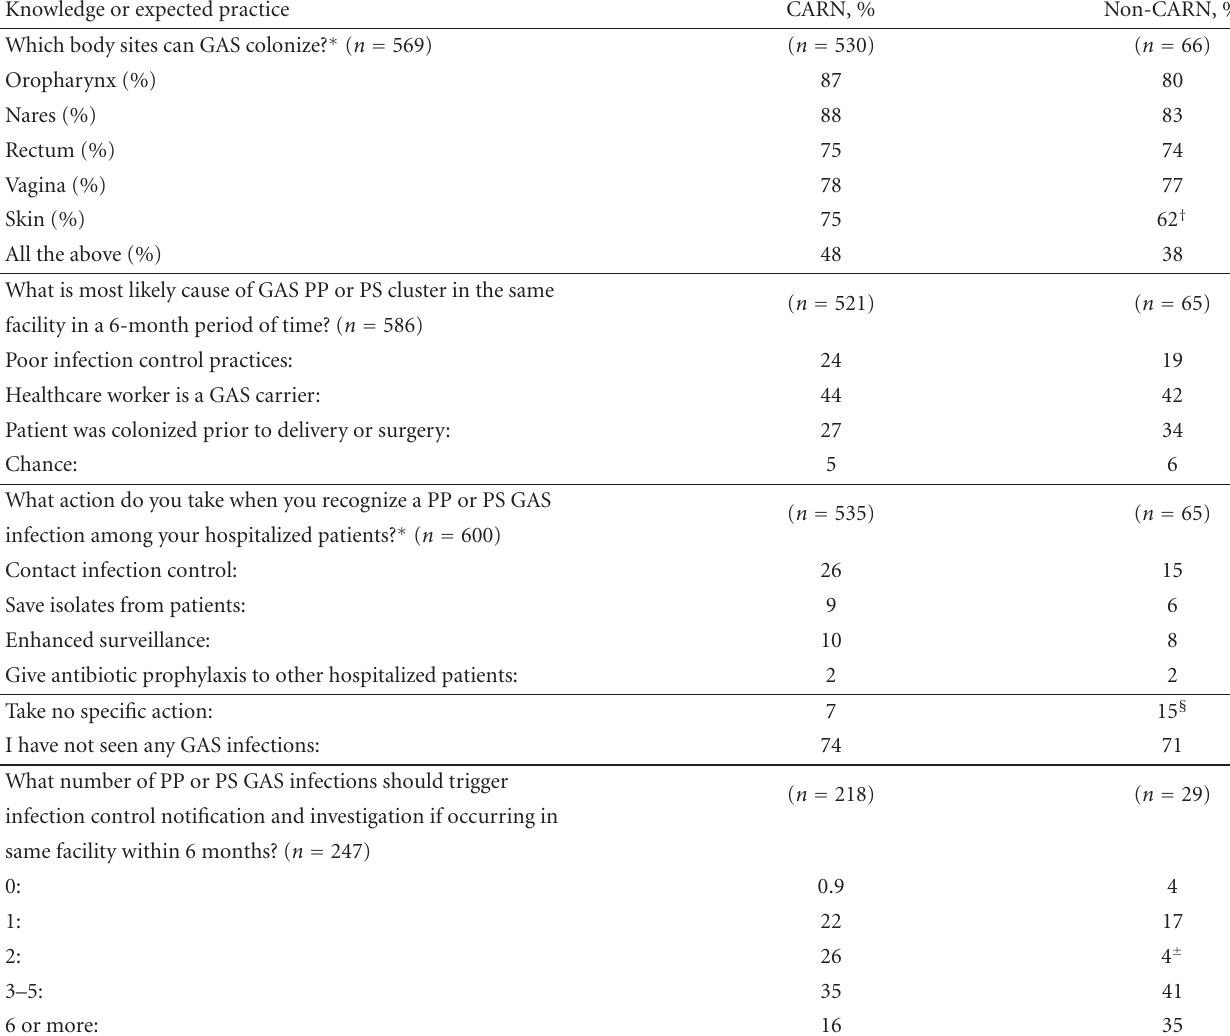
Table 3: Survey respondents’ knowledge and expected practice patterns regarding group A streptococcal (GAS) postpartum (PP) and post- surgical (PS)